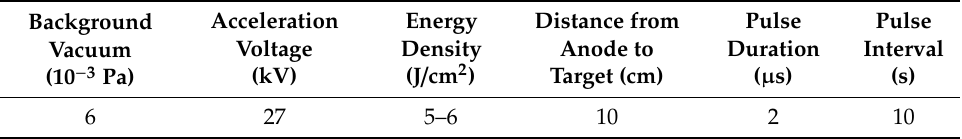
Table 1. Process parameters of high-current pulsed electron